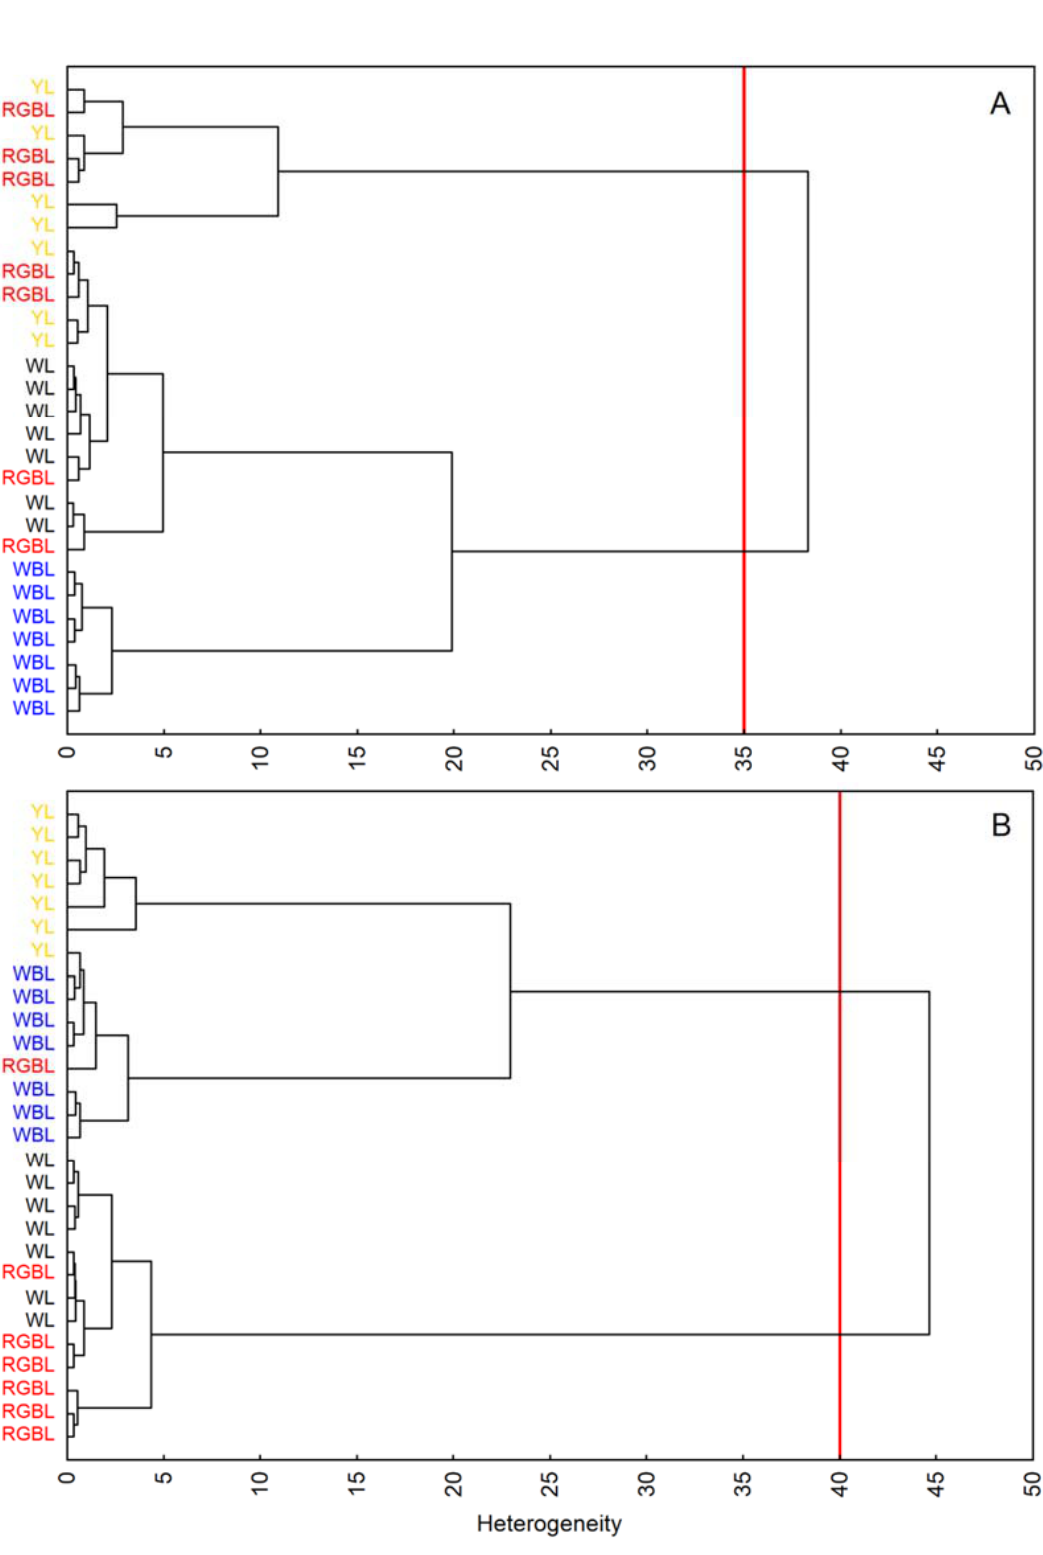
Figure 4. Dendrograms of a hierarchical cluster analysis according to Ward’s algorithm of the FT ‐ Raman spectra obtained for the leaves of Brassica rapa subsp. pekinensis growing under different spectral compositions of light. ( A ) Control plants and ( B ) plants fumigated by ozone (21 days, 100 ppb). The red line indicates the number of statistically significant groups to which individual objects have been classified.